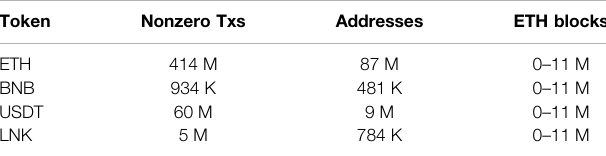
TABLE 2 | Summary of the datasets analysed in this